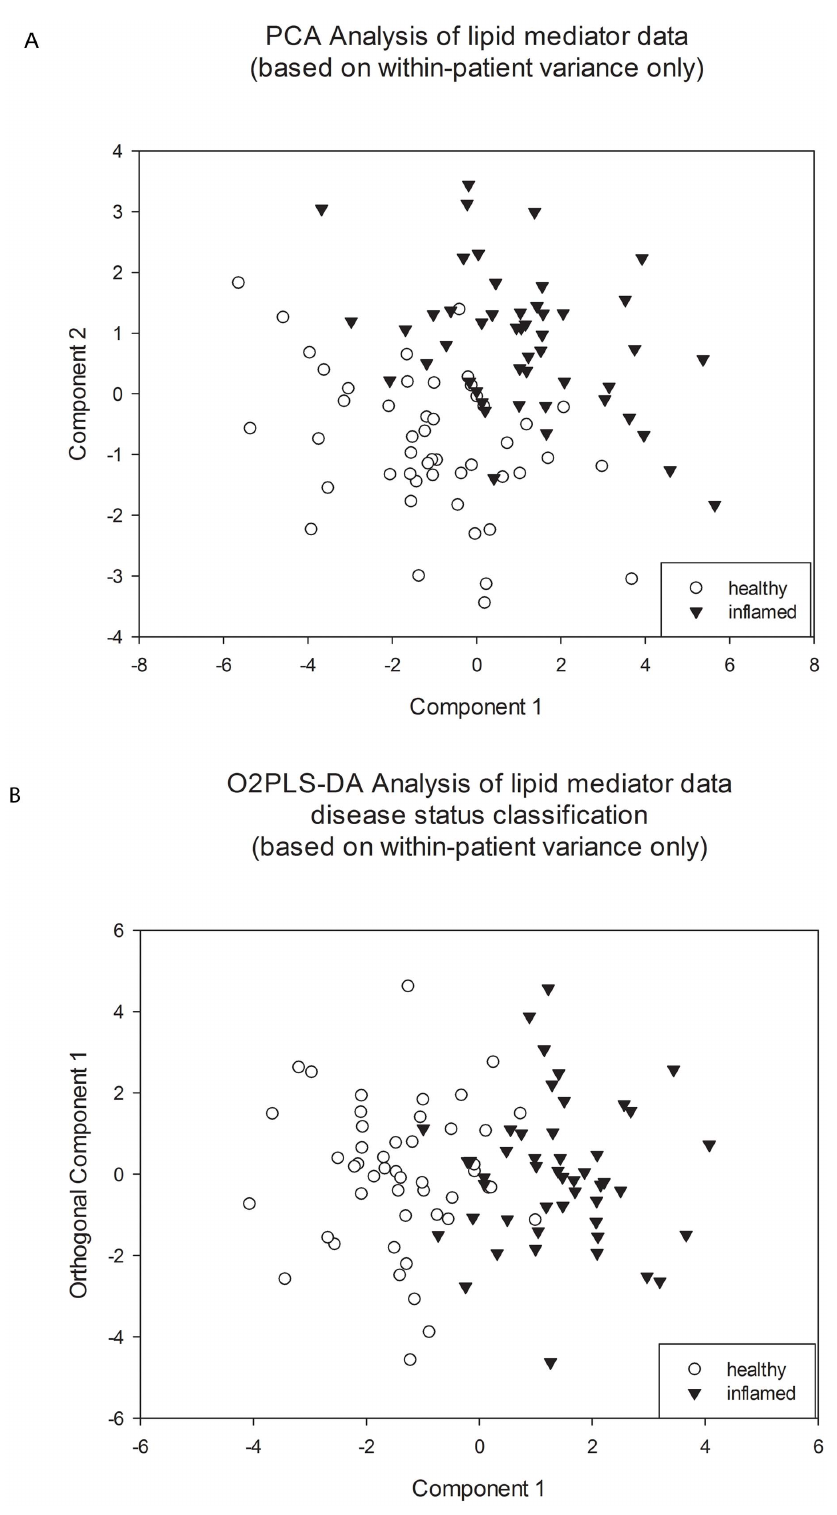
Figure 4. Data separation of inflamed (triangle) and non-inflamed (circle) mucosa based on lipid mediator concentration. 4A: PCA score plot (unsupervised analysis); 4B: O2PLS-DA plot (supervised analysis). doi:10.1371/journal.pone.0076532.g004 the levels of PGD 2 in inflamed tissue, although its metabolite 15- Sub-group analysis ( n 18) of a group of patients not receiving deoxy D 12,14 PGJ 2 was not detectable in mucosal biopsies. corticosteroids and 5-ASA confirmed significant differences in